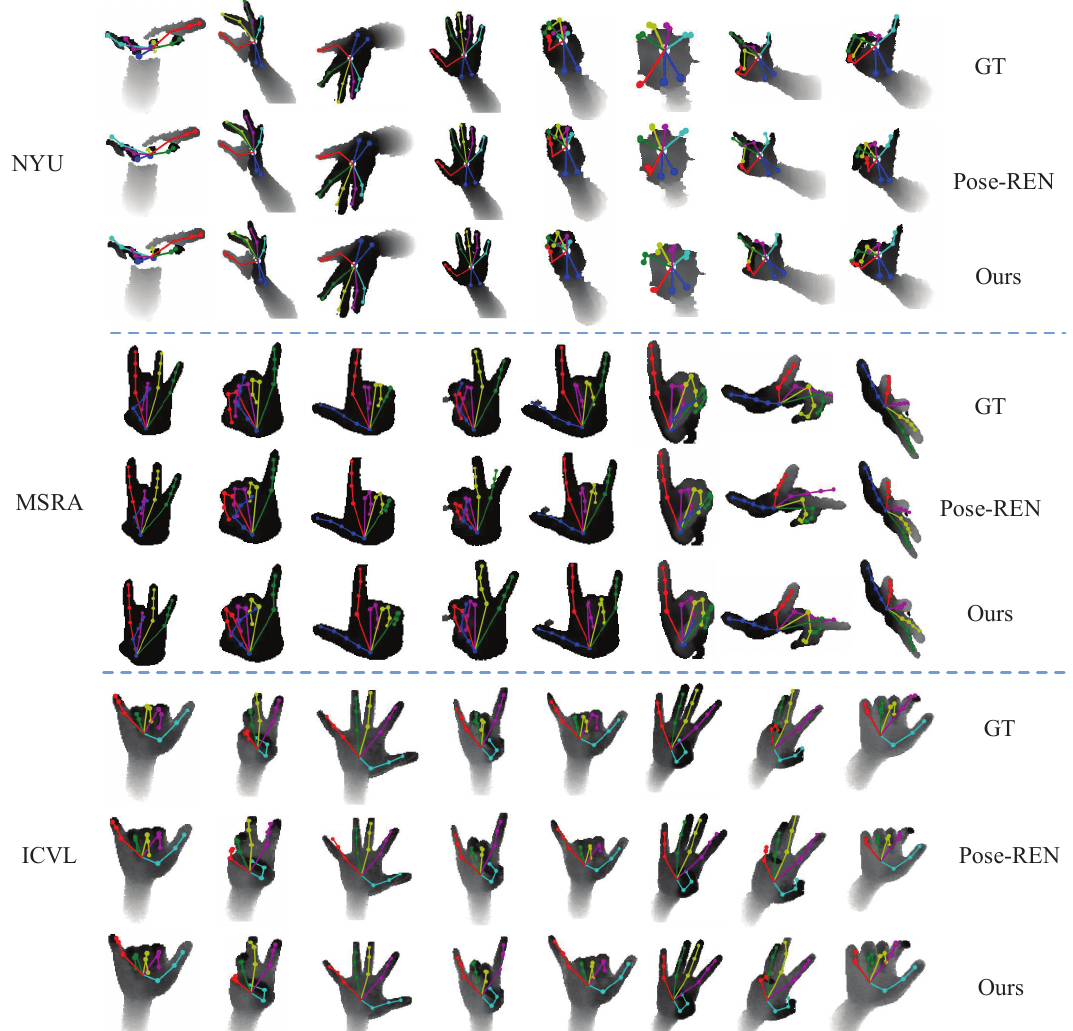
Figure 9. Qualitative results. For each dataset, three rows show the results from pose-guided structured region ensemble network (Pose-REN) [17], our method (Ours) and ground truth (GT), respectively. (Best viewed on